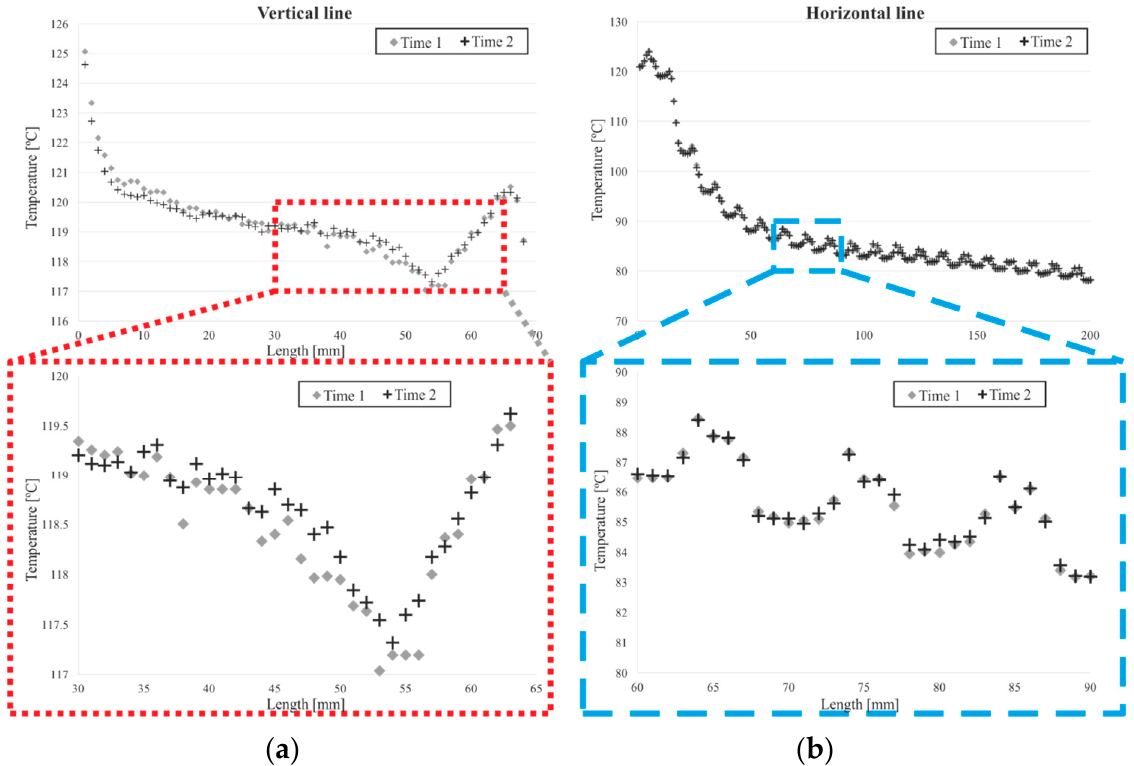
Figure 13. Comparison of temperature measurements following the methodology, in the same line, at two different moments. Analysis of a vertical line ( a ), and a horizontal line ( b ).